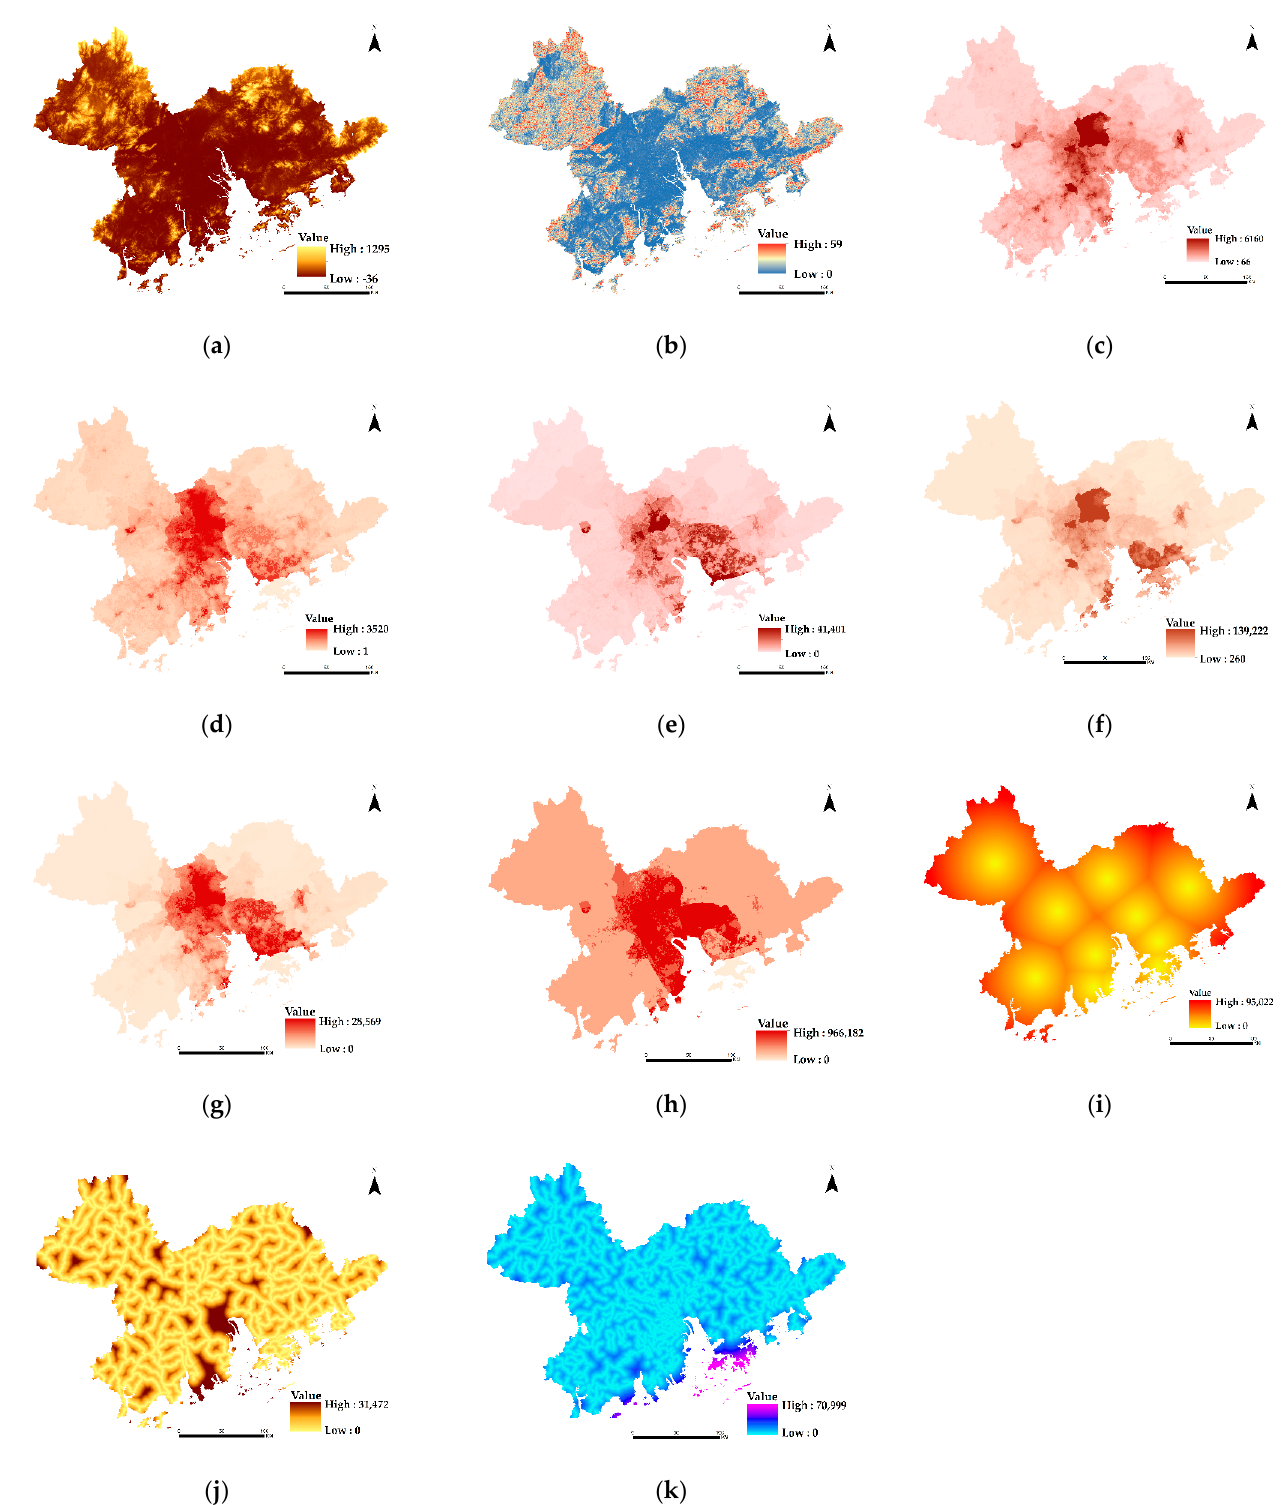
Figure 7. Spatial Variables: ( a ) DEM, ( b ) slope, ( c, d, e ) population 1995–2015, ( f, g, h ) GDP 1995–2015, ( i ) distance from city, ( j ) distance from roads, and ( k ) distance from streams.